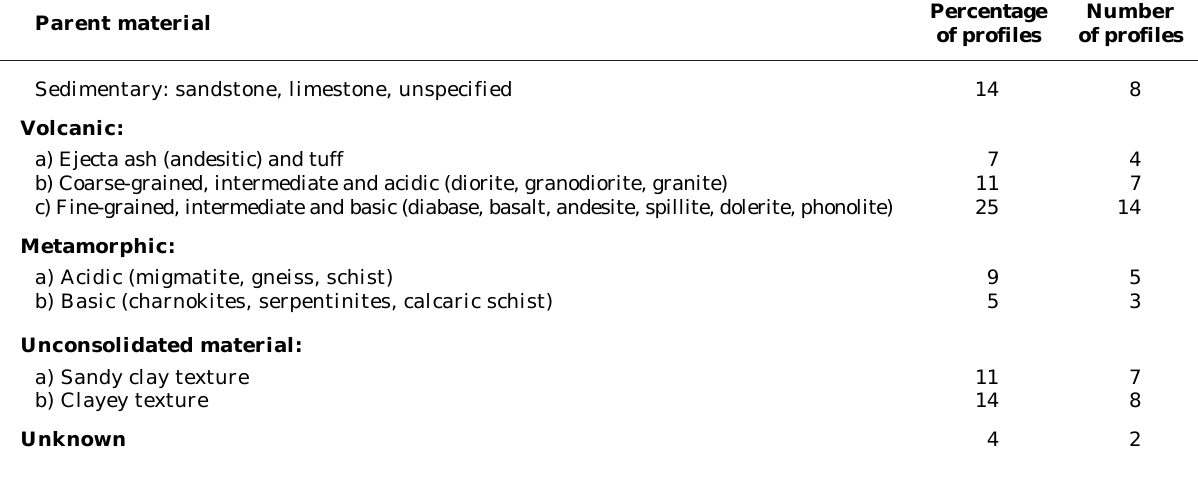
Table 2. Distribution of the profiles according to parent